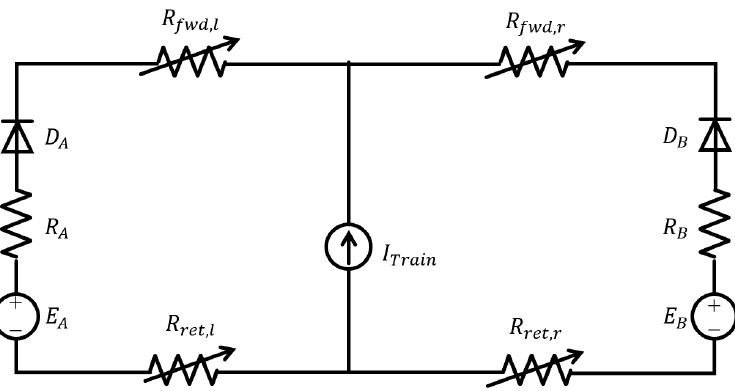
Figure 6. Circuit of moving train load using varying resistance.